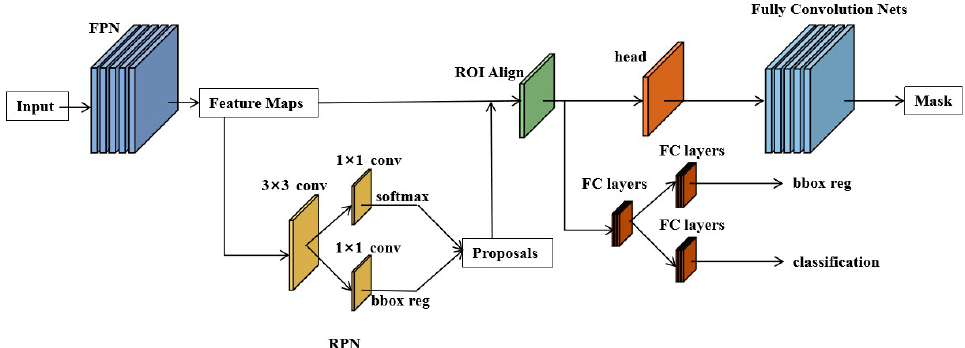
Figure 3. Mask-R-CNN framework for instance segment.